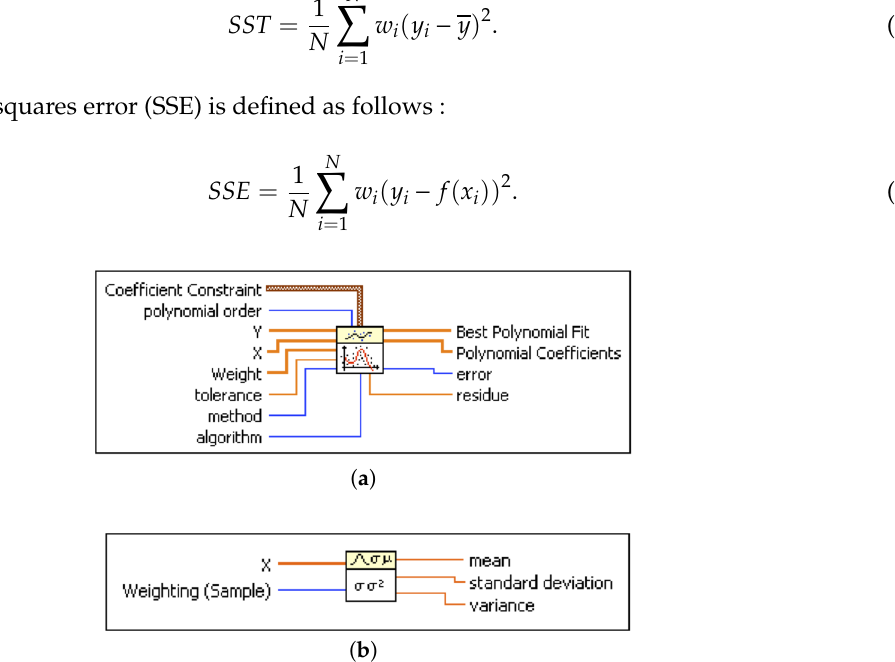
Figure 10. General Polynomial Fit VI ( a ) and Standard Deviation and Variance Virtual Instrument ( b ) of LabVIEW [48].